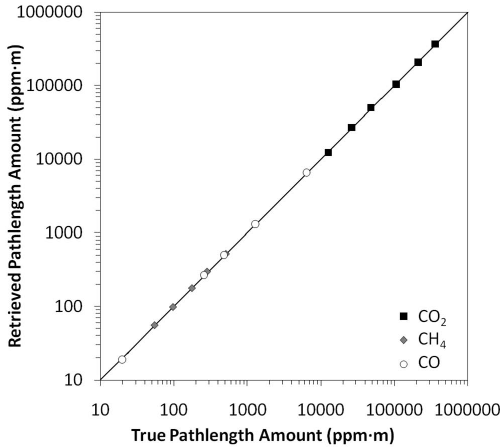
Fig. 13. Relationship between mean retrieved pathlength trace gas amounts made using the optimum parameterisation of the MALT model determined herein. The 1:1 line is shown and all retrieved amounts are within 4.8% of true amounts (note logarithmic